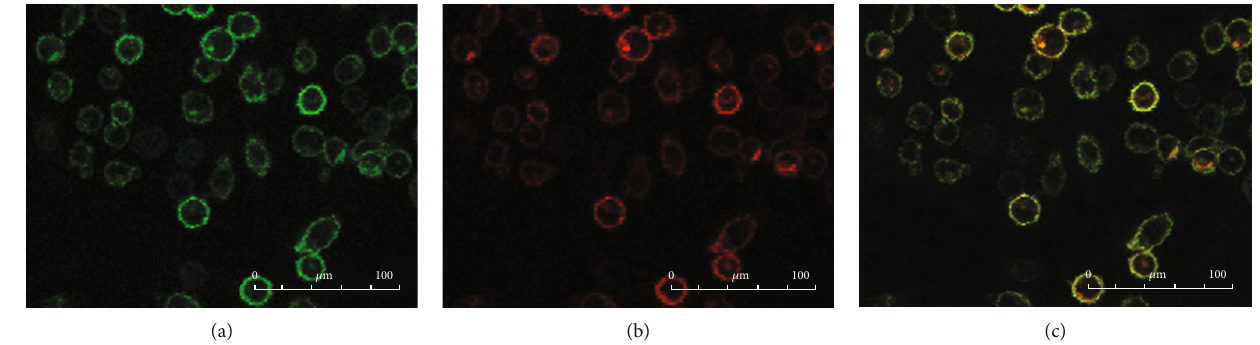
Figure 1: Immuno fl uorescence staining of TLR4 and CD14. (a) CD14 identi fi es monocytes. The cells were nearly round. (b) Some monocytes expressed TLR4 without LPS stimulation; TLR4 mainly expressed on the cell membrane. (c) Without LPS stimulation, some monocytes coexpress TLR4 and CD14.